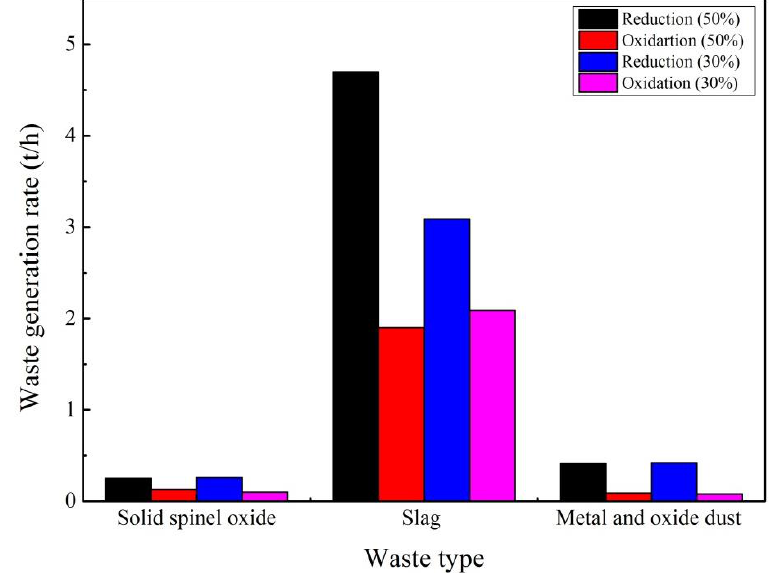
Figure 8. Solid waste generation rate (t/h).